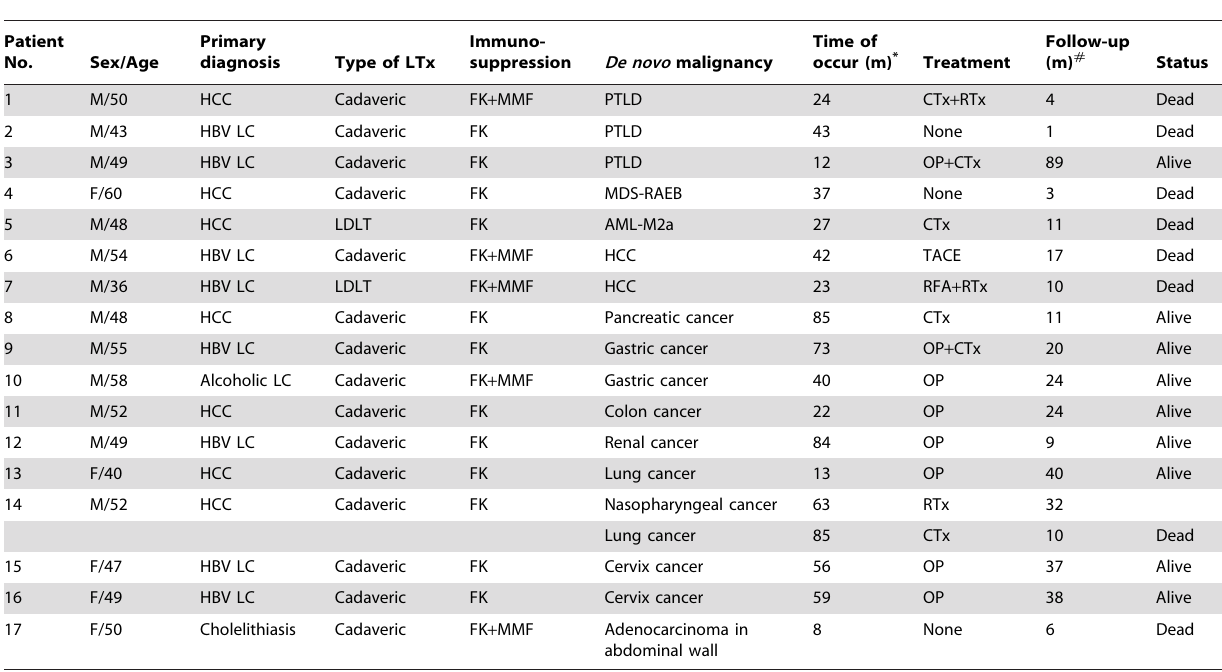
Table 2. Demographic and clinical features of the patients with de novo malignancy.